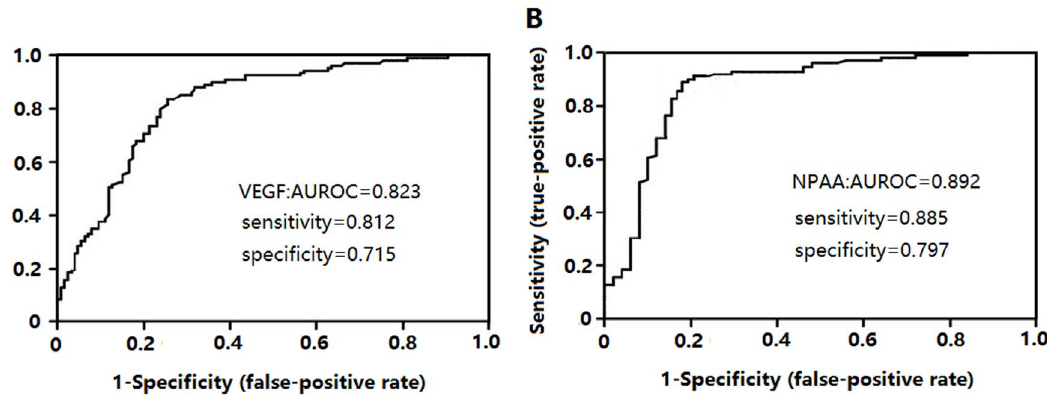
Figure 1. Receiver-operating curve (ROC) analysis of platelet derived VEGF and NPAA in the detection of lung cancer. (A,B) ROC analysis of lung cancer patients and healthy controls, and healthy controls as a negative group and patients with lung cancer as a positive group.